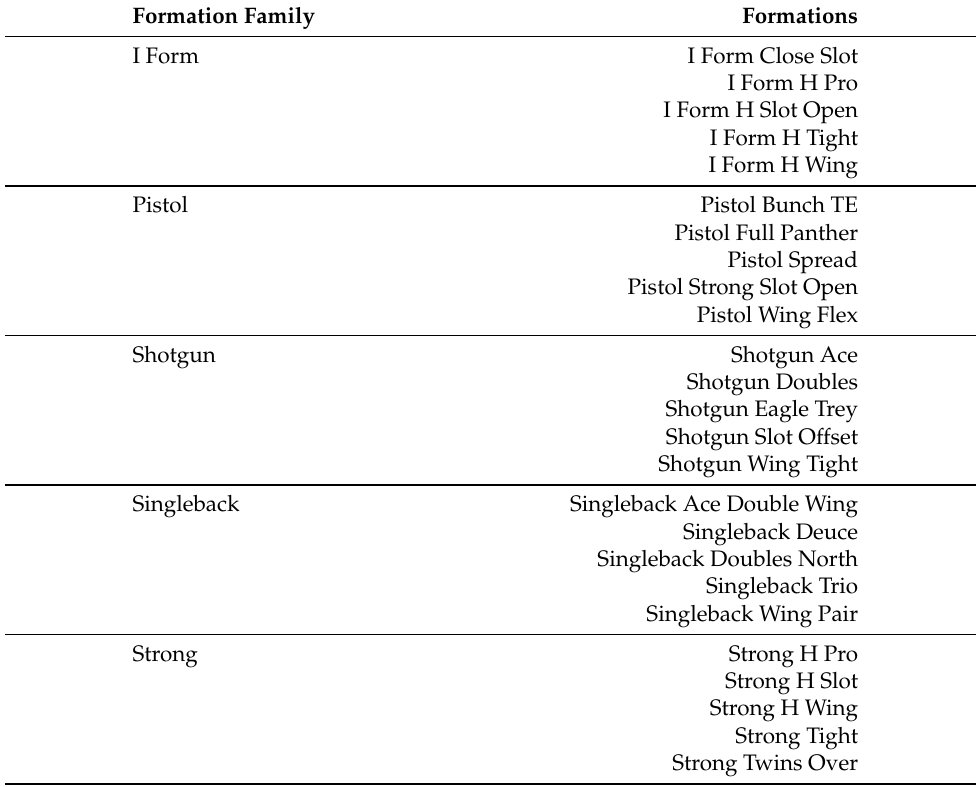
Table 3. The five formation families selected for our study. Each consists of five formations. Formation